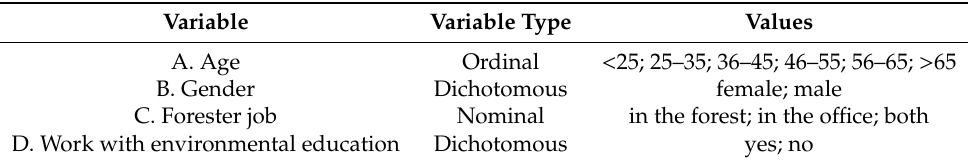
Table 2. List of independent